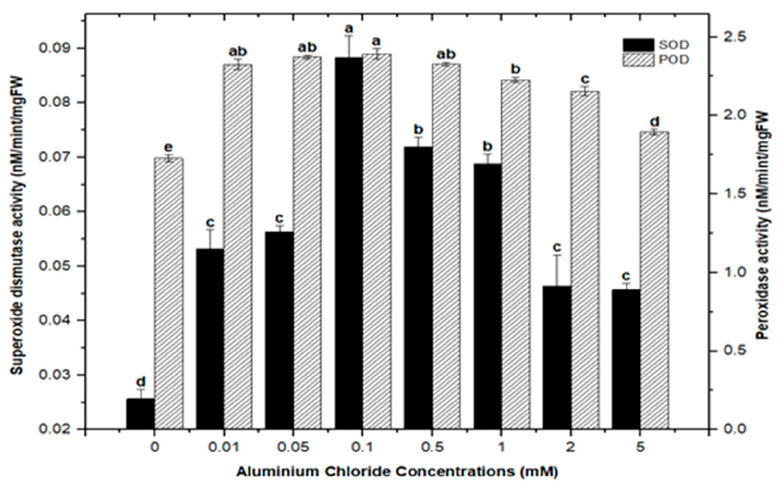
Figure 11. Superoxide dismutase and peroxidase activity of F. indica calli elicited with seven different concentrations of aluminum chloride along with the control. Bars labeled with different letters (LSD values) exhibit significant variation ( α < 0.05).